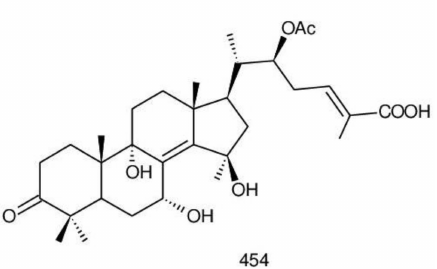
Figure 19. Chemical structure of ganorbiformin A ( 454 ) as a rearranged novel